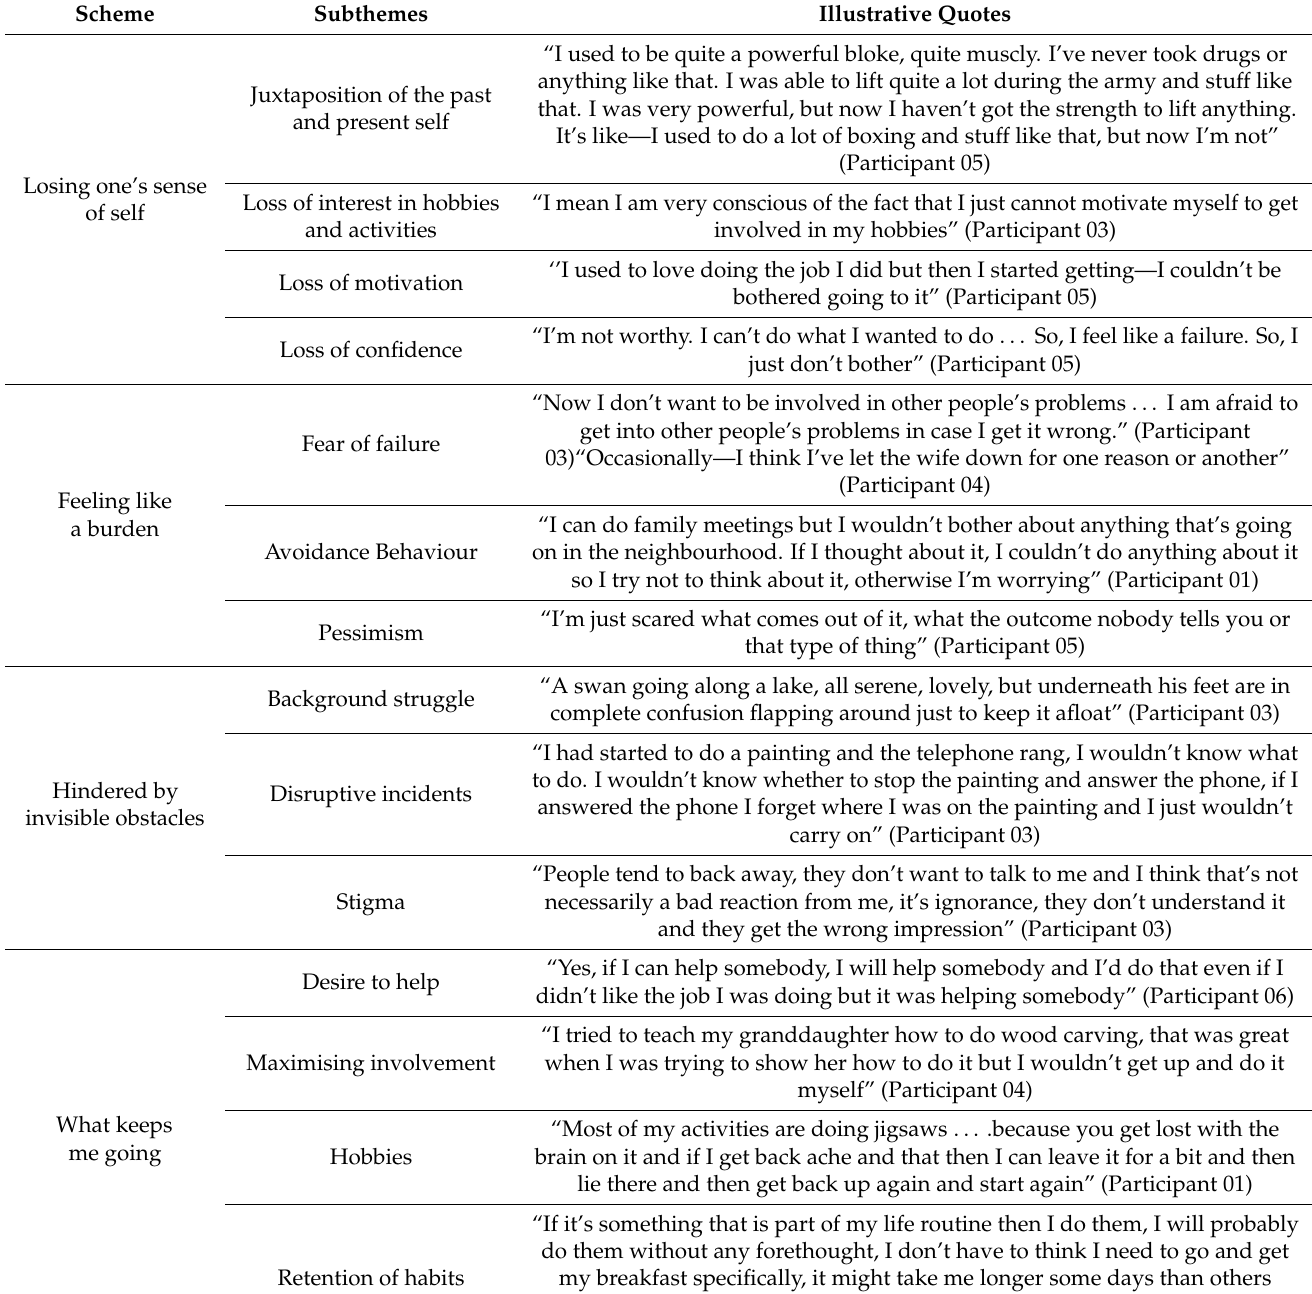
Table 2. Superordinate themes, subthemes, and illustrative